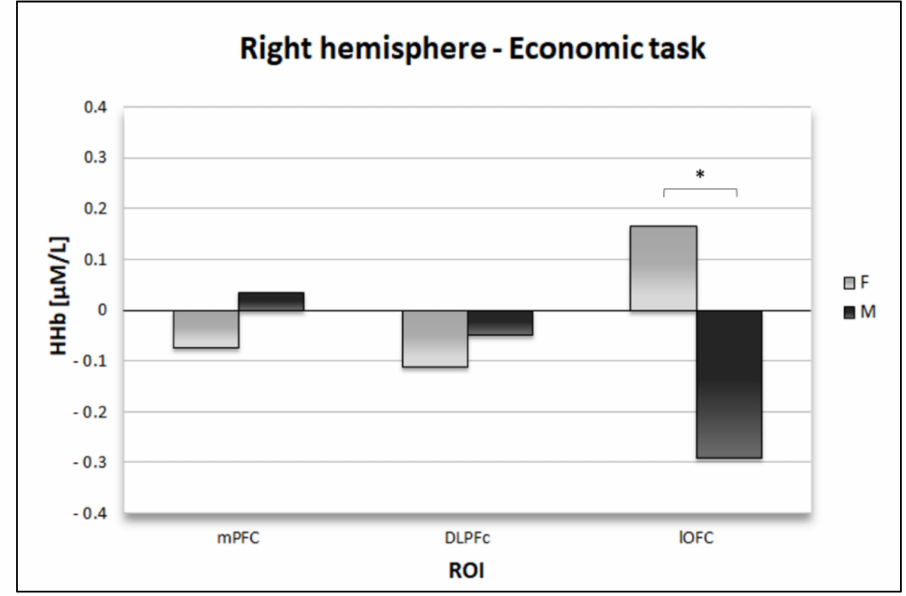
Figure 5. Histogram representing di ff erences in the right-hemisphere brain activity between males and females during the economic task. Statistically significant comparisons are marked with an